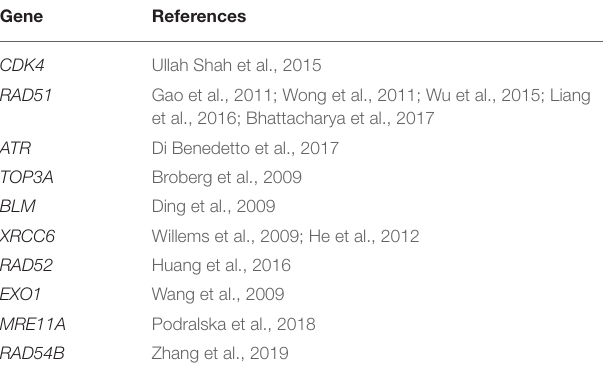
TABLE 3 | Predicted top 10 candidate genes for breast cancer using PPI and KEGG pathway.